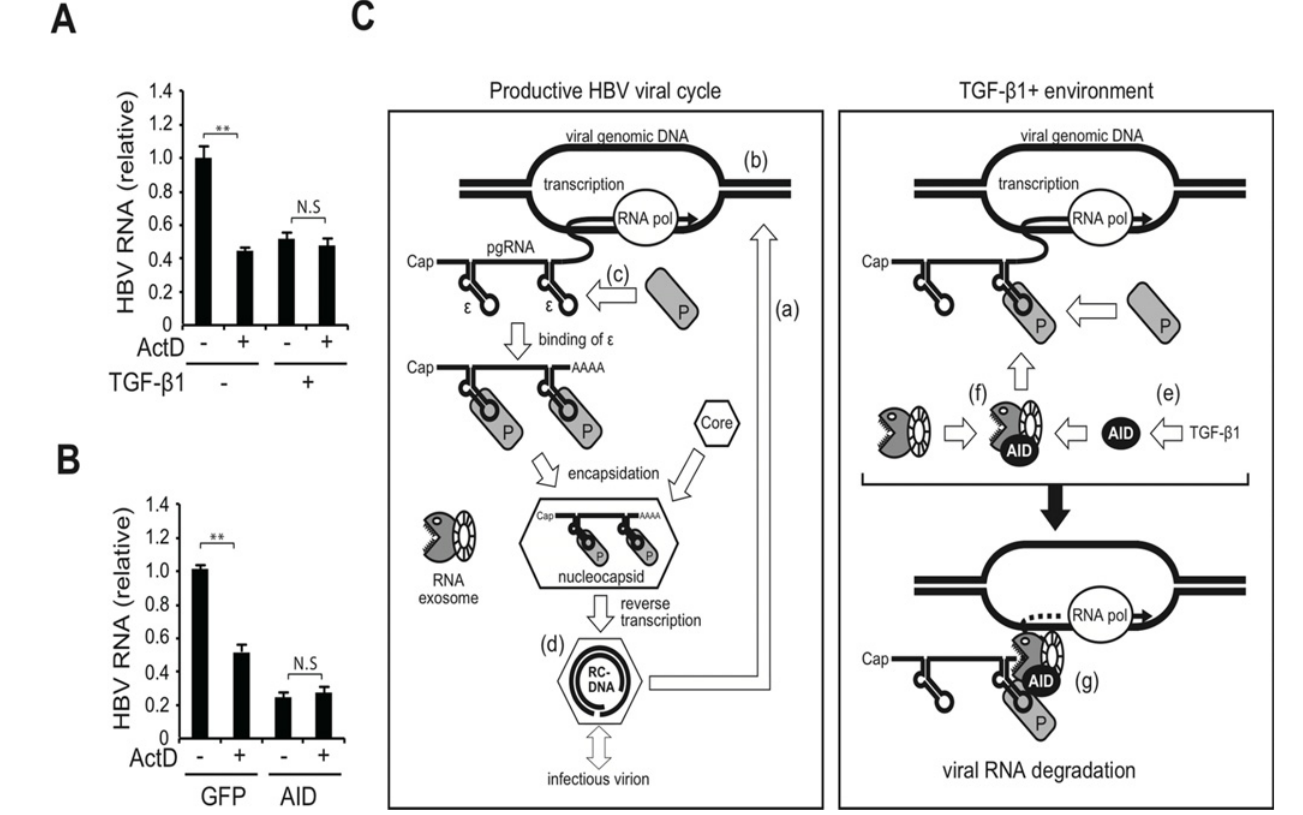
Fig 8. Transcription dependency for TGF- β 1-mediated reduction of HBV transcripts and a proposed model. HBV-expressing 7T7-8 cells were treated with 10 ng/ml TGF- β 1 (A) or transfected with AID (or GFP) expression plasmid (B) and cultivated for 3 days. At 18 h before harvest, 100 ng/ml actinomycin D (ActD) was added to block transcription. Total RNA was extracted to measure HBV RNA levels (normalized by HPRT) by qRT-PCR. HBV RNA levels in non- treated (A) and GFP transfected cells (B) were taken as one. ** P < 0.01 ( t -test); Data are representative of two independent experiments and error bars represent standard errors of the mean. (C) Hypothetical model: Left panel, the canonical HBV life cycle; (a) After the entry of HBV into a hepatocyte, nucleocapsid NC-DNA is converted into cccDNA. (b) Subsequently, cccDNA expresses viral transcripts, including pgRNA, pre-S1, pre-S2/S, X, and pre-C mRNAs. In this study, most viral RNAs were transcribed from the HBV plasmid instead of cccDNA. All transcripts possess the 3 0 - ε RNA stem-loop structure; only pgRNA is shown. (c) P protein binds to the ε structure and stabilizes it, and the core protein (indicated by hexagons) is then recruited to form the nucleocapsid. (d) Inside the nucleocapsid, P protein reverse transcribes pgRNA to produce NC-DNA. A mature nucleocapsid gains S proteins and is secreted as an infectious virion. The minor fraction of nucleocapsid may enter a second intracellular viral cycle. (e) Right panel, TGF- β 1 stimulation of hepatocytes induces AID expression. (f) AID associates with the RNA exosome proteins. The RNA exosome comprises ring-like core and exonuclease catalytic components. AID associates with HBV transcripts and P proteins. (g) Consequently, AID bridges the RNA exosome with the RNP complex of HBV transcripts and P protein, which may trigger the degradation of HBV